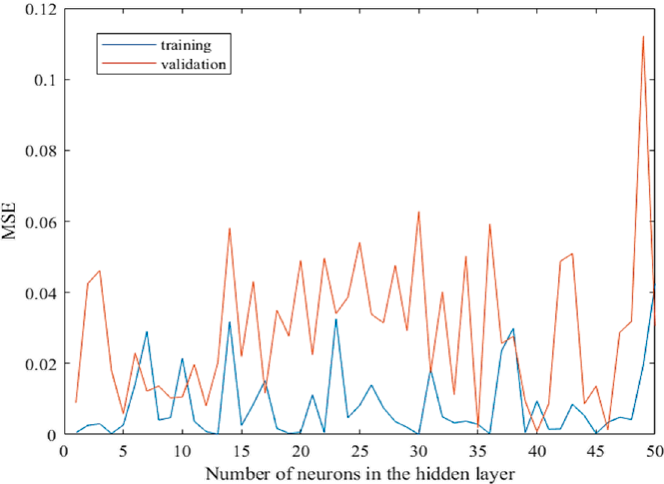
Figure 3. MSE values after optimization of the initial model.